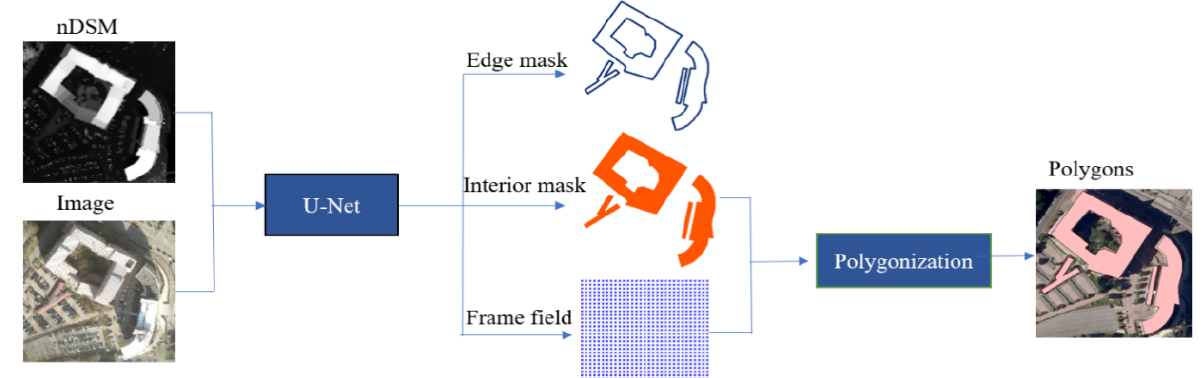
Figure 1. The w orkflow of the investigated frame-field method for building delineation fusing nDSM and RGB data. Adapted from Girard et al., (2020).